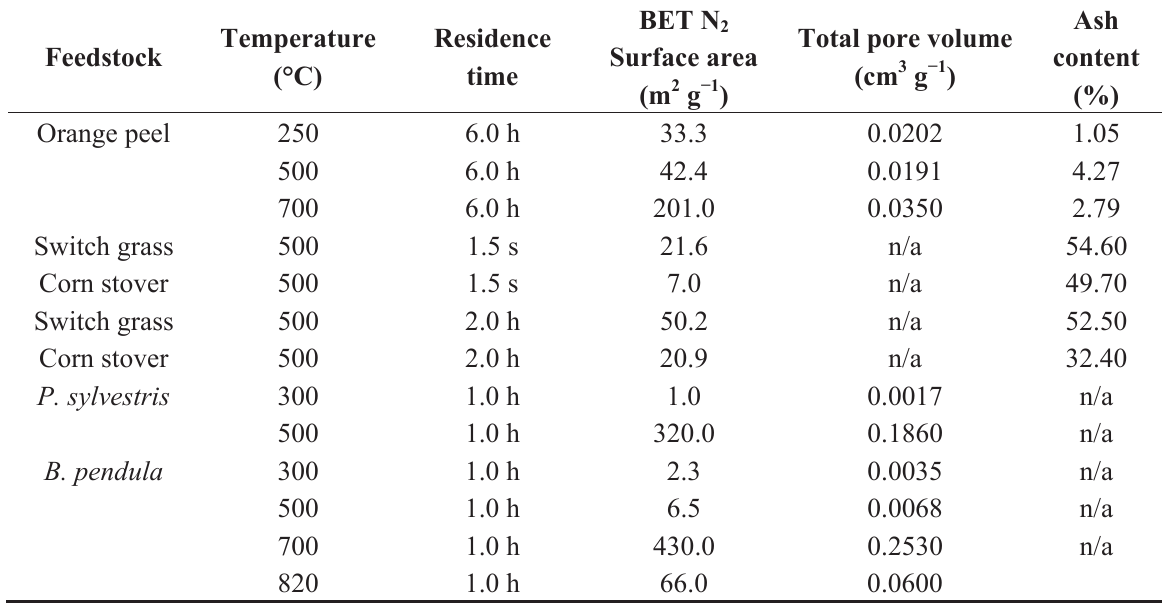
Table 2. Characteristics of biochar from different production processes